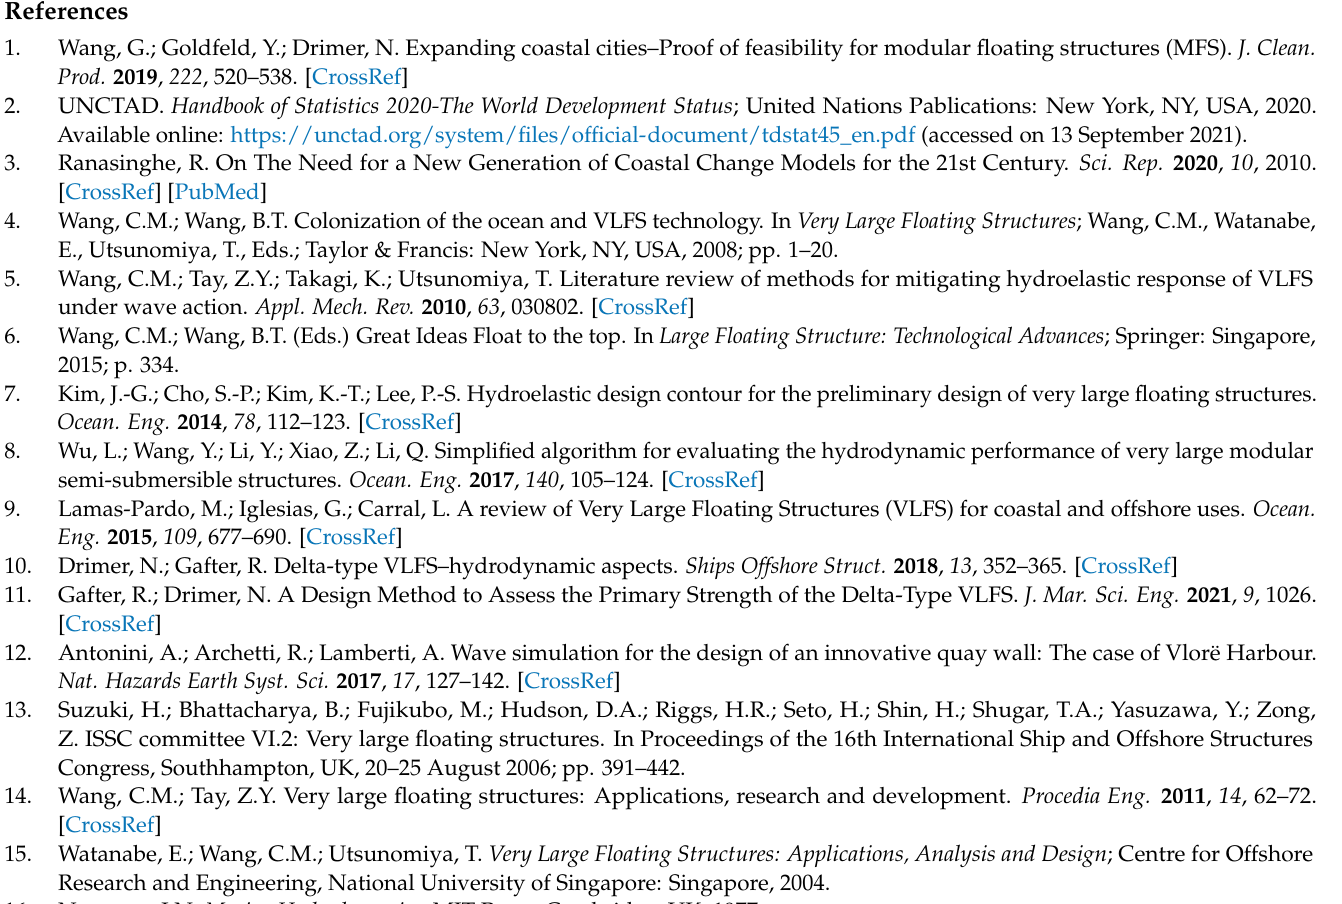
Figure A8. Load case s4 (H mo = 3.5 m)—wave frequency position. The surge and sway positions are relative to the position of the Delta, the other positions are absolute position of the ship.